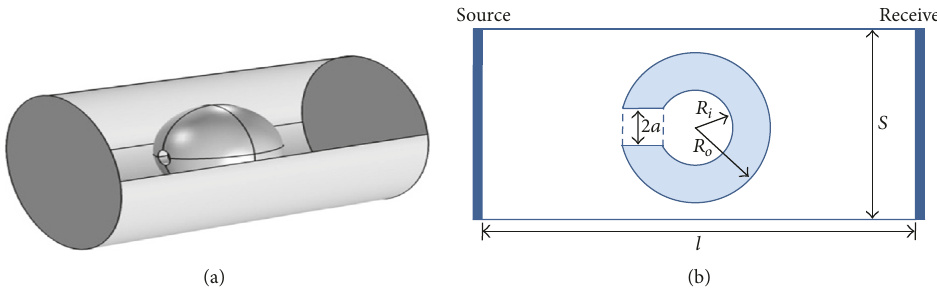
Figure 1: (a) The 3D scheme of the metamaterial unit cell. (b) The cross section of the cell.